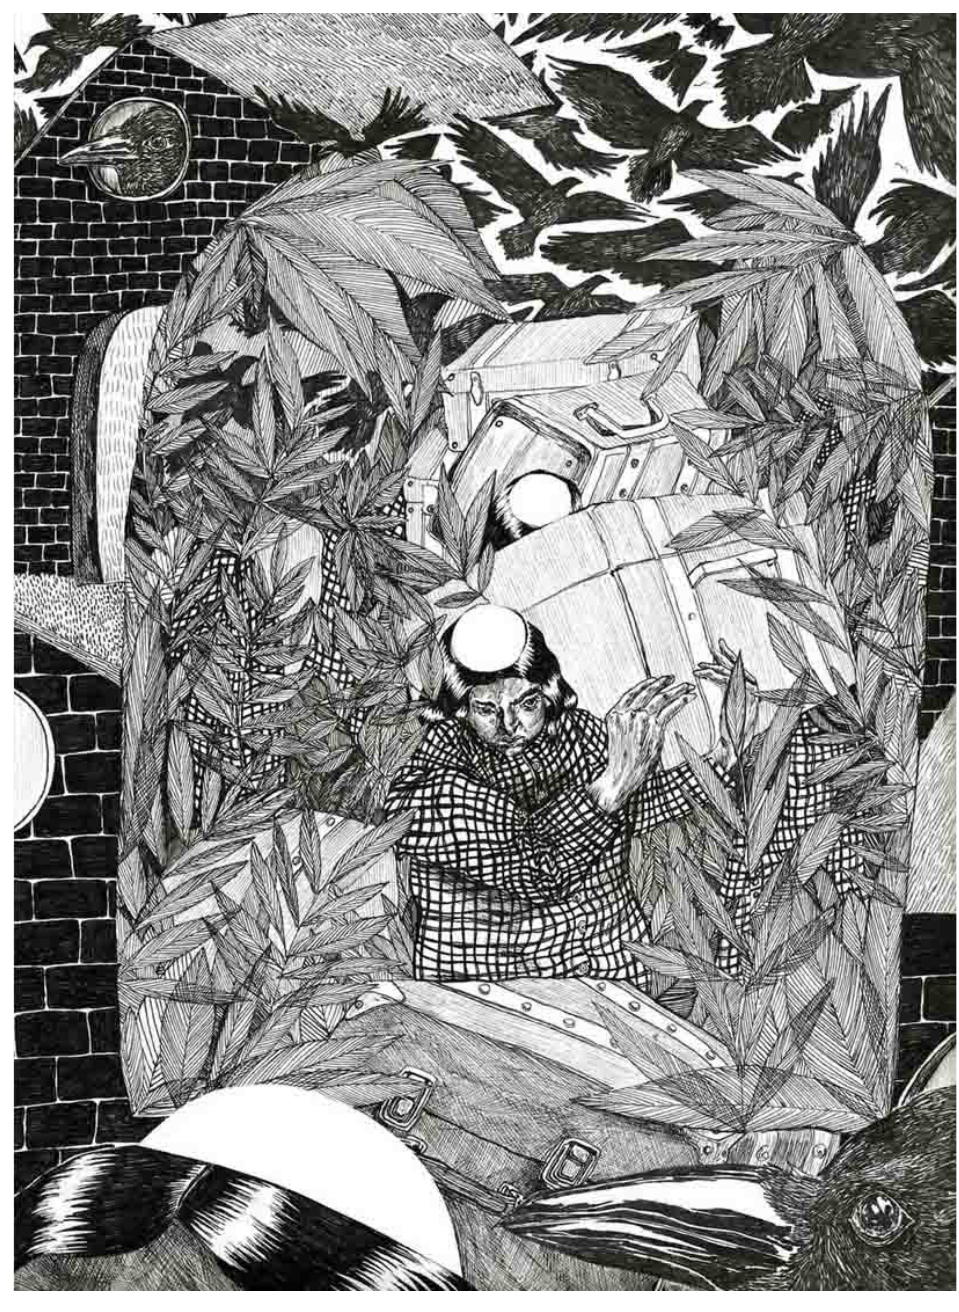
Rosabel Rosalind Kurth-Sofer, Exodus VIII , 2018. Pen and ink on paper. 9x11